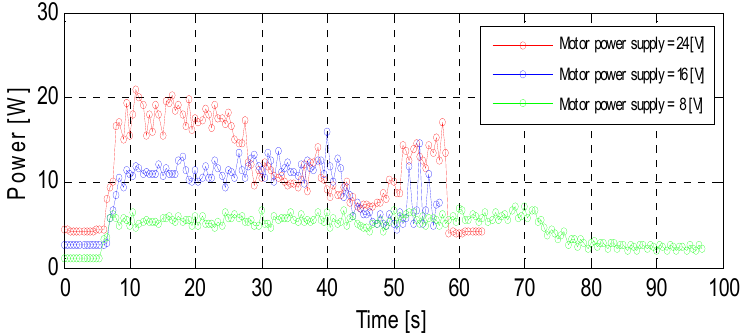
Figure 5. Power consumption during drillability test performed for Ytong (compression strength Re